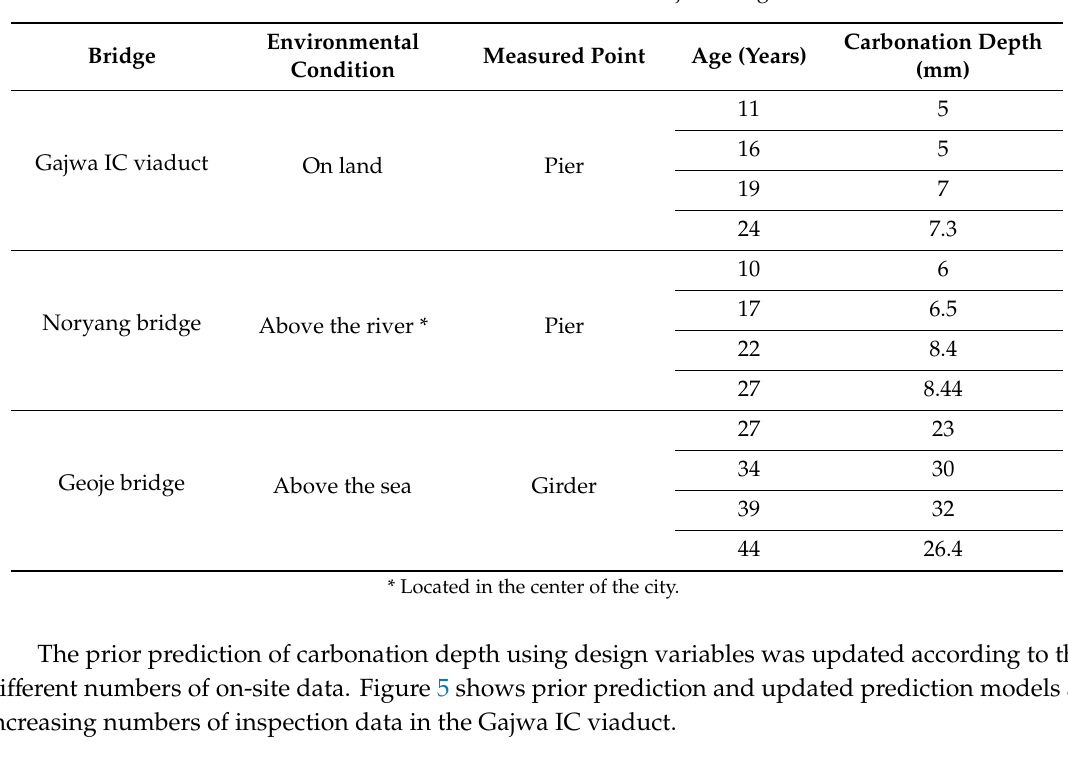
Table 3. Carbonation on-site data of subject bridges.